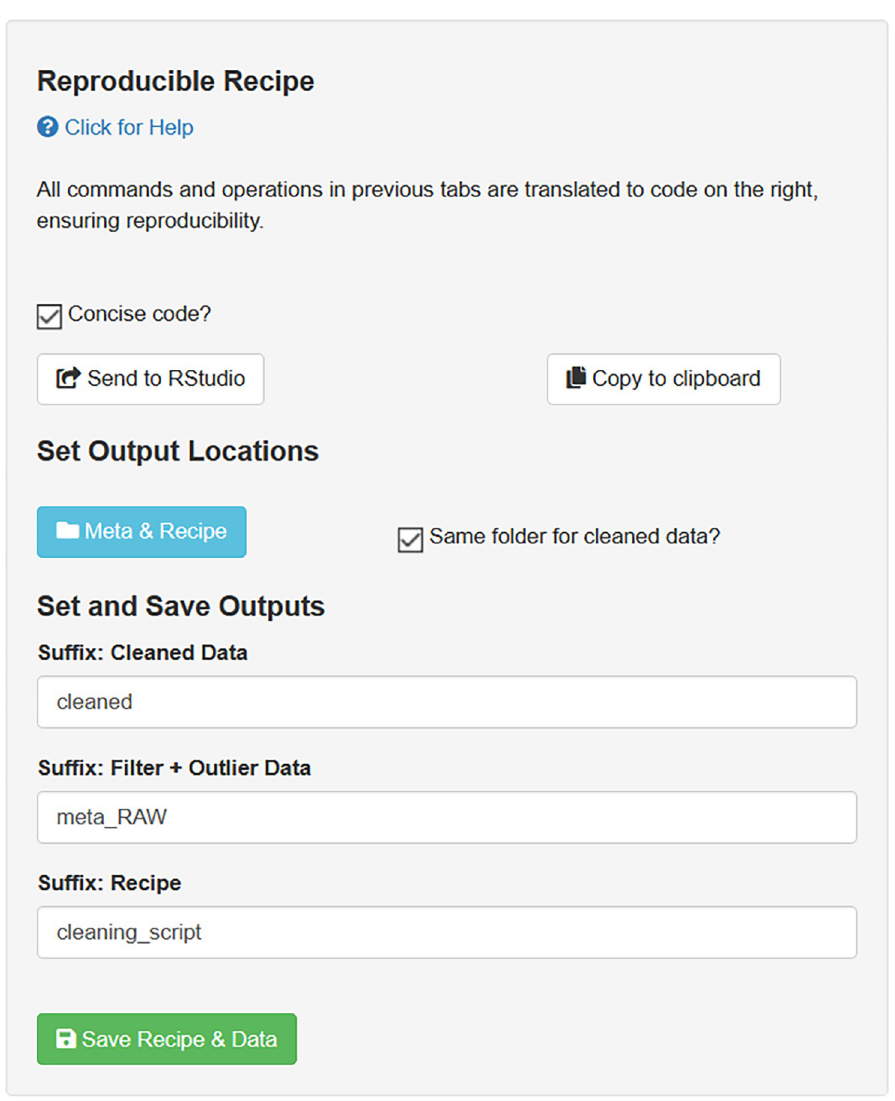
Fig 4. Code recipe extraction. Options provided in the Extract Recipe tab for defining and saving outputs when datacleanr is launched with a file path. Copying or sending the recipe (i.e. R code) to an active RStudio 1 [29] session is always